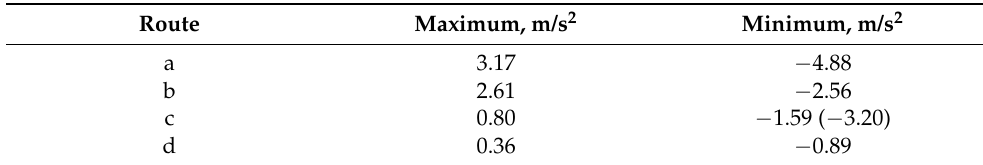
Table 2. Lateral acceleration at specific road types.